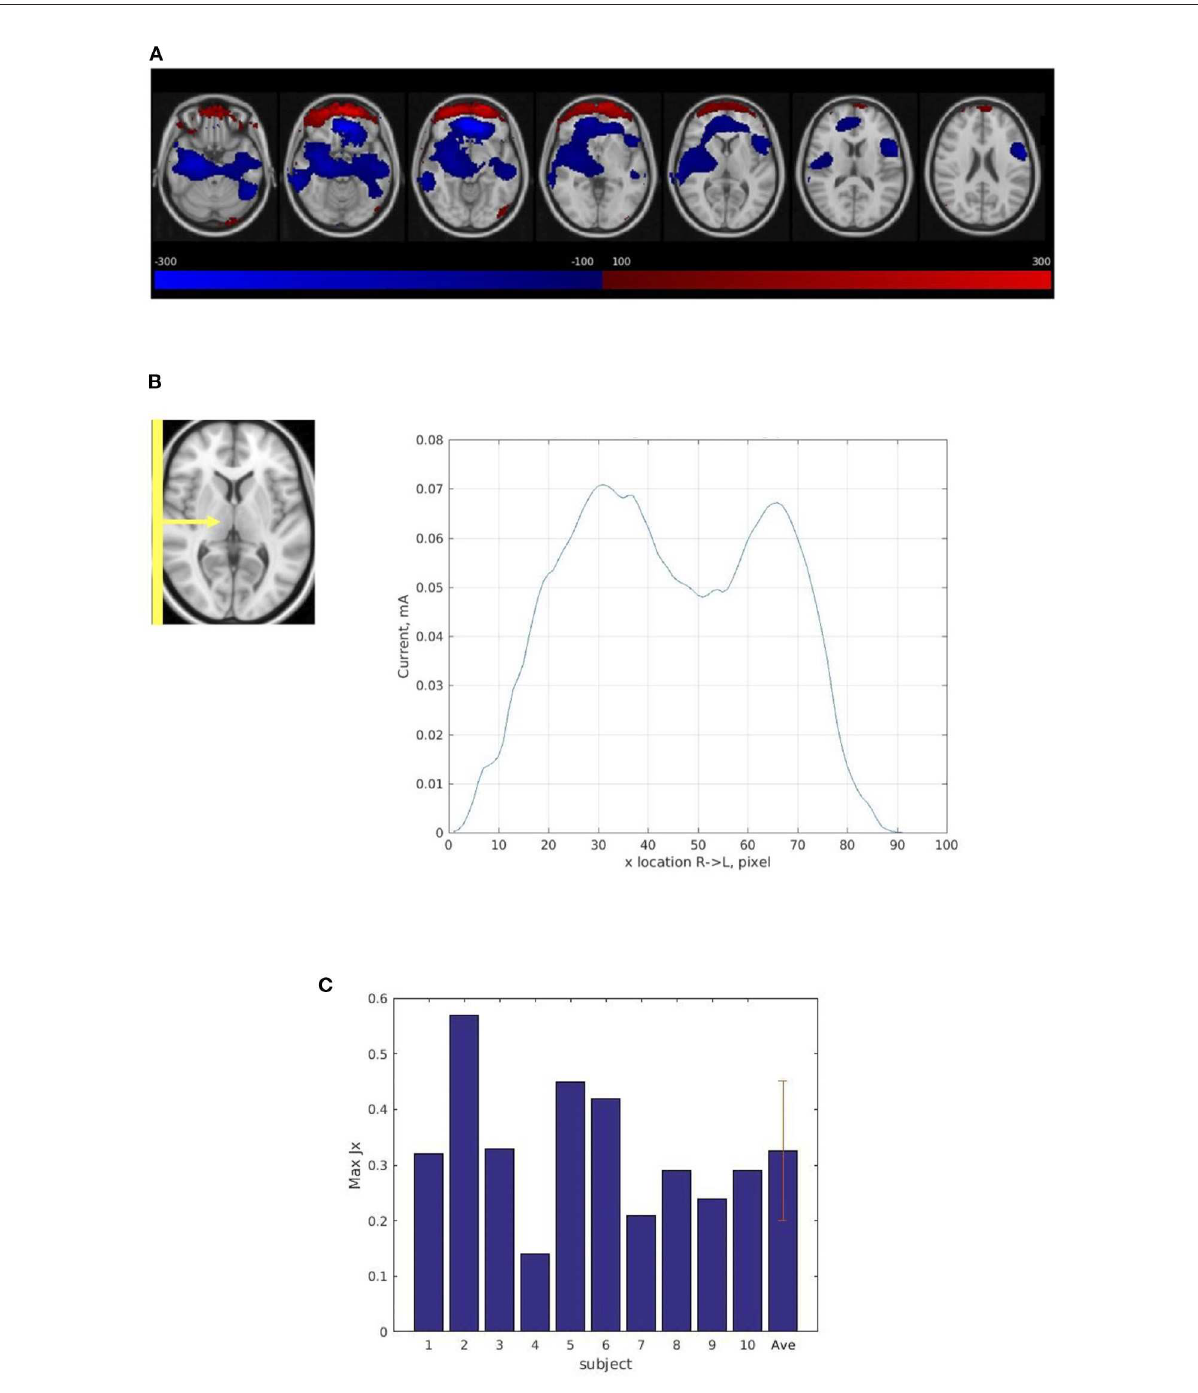
FIGURE4 Current distribution in human subject experiments. (A) The average current distribution map across ten subjects normalized into a common atlas (MNI152_T1_2mm) using the T2 anatomic images. The maps show Right (R) to Left (L) (J x ) current flow in the brain. The blue area shows Right to Left current flow (the primary direction). The red area shows Left to Right current flow which indicates an artifact of boundary conditions at the edge of the brain near the frontal orbital region where susceptibility changes rapidly. (B) Magnitude of Right (R) to Left (L) current flow (J x ) in 3-pixel-thick slabs in the sagittal plane in normalized space averaged across ten subjects’ average current distribution maps from the four consecutive scans. The maximum total sum of the current (J x ) passing through the sagittal plane is 0.07mA. (C) The maximum total sum of magnitude of Right (R) to Left (L) (Jx) current in 3-pixel-thick slabs in the sagittal plane in ten subjects, subject average, and standard deviation. The average maximum total sum of the current passing through the sagittal plane is 0.33 ±